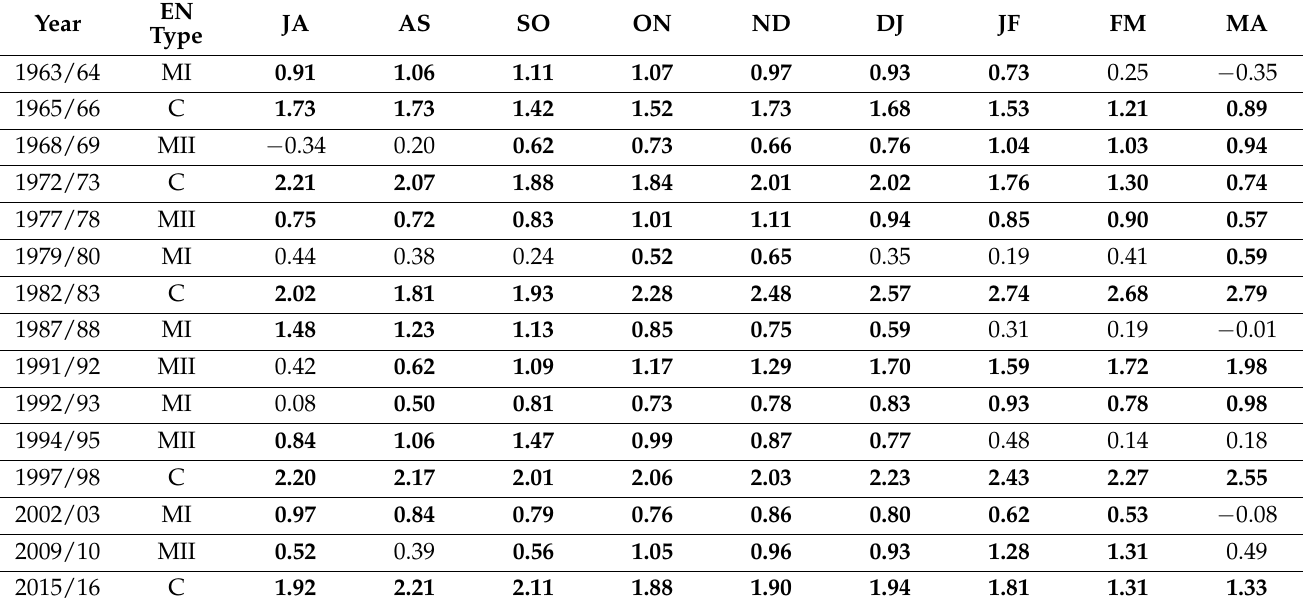
Table 1. Bimonthly MEI index values. Positive values with magnitudes greater than 0.5 highlighted with